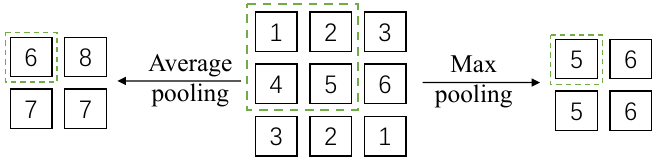
Figure 8. Pooling operation.